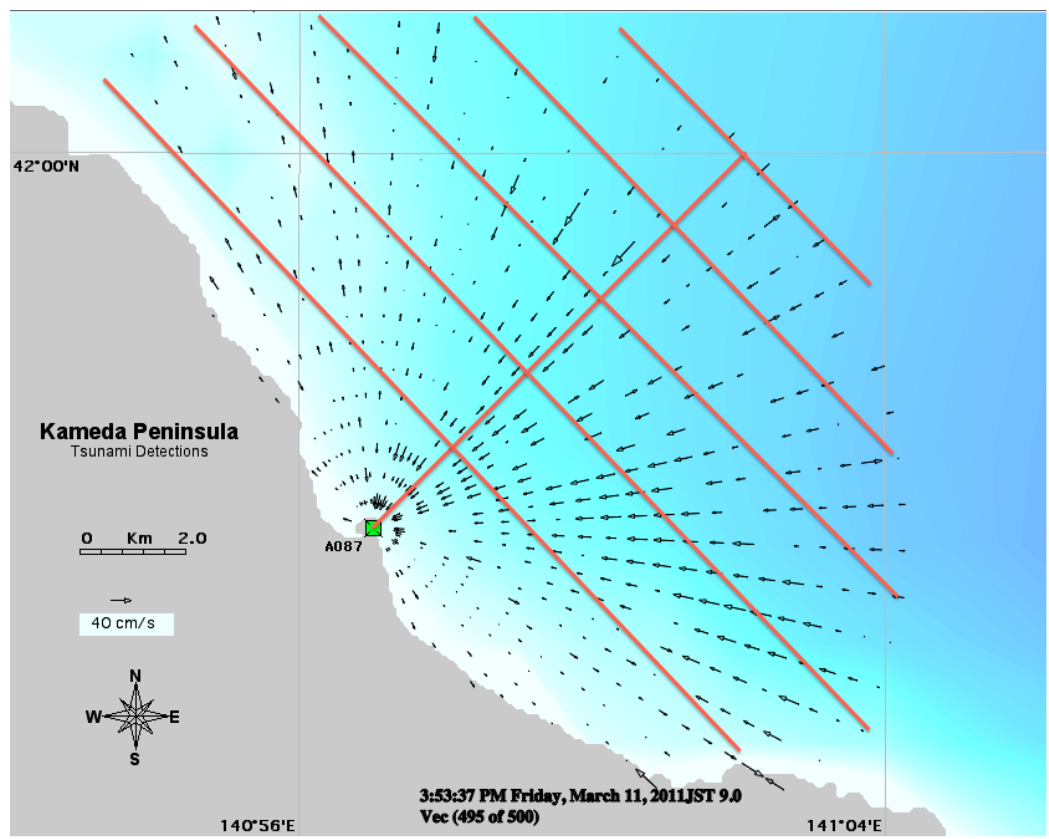
Figure 1. Radial current velocities from the Usujiri, Hokkaido radar and the area bands used in the analysis which are 2-km wide and approximately parallel to the depth contours.